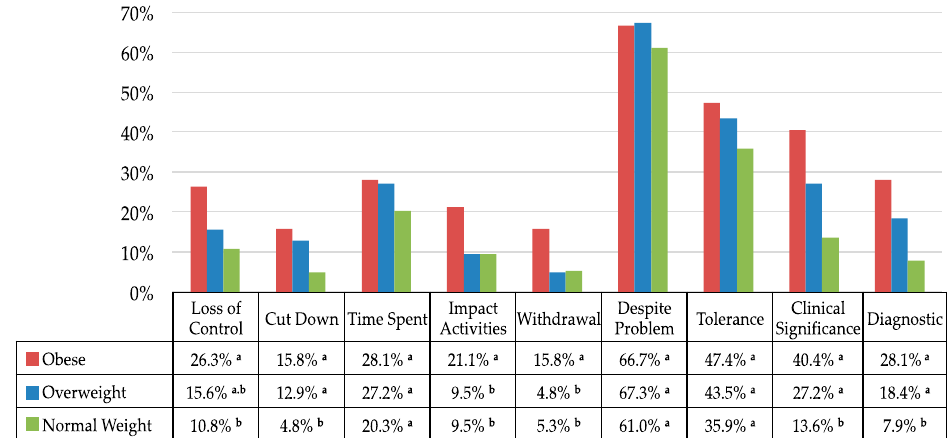
Figure 1. Prevalence of modified Yale Food Addiction Scale ( mYFAS ) symptoms and food addiction diagnosis by BMI group. For each pair of BMI groups, the proportions are compared using a z-test. If a pair of values is significantly different, the values have different subscript letters assigned to them.